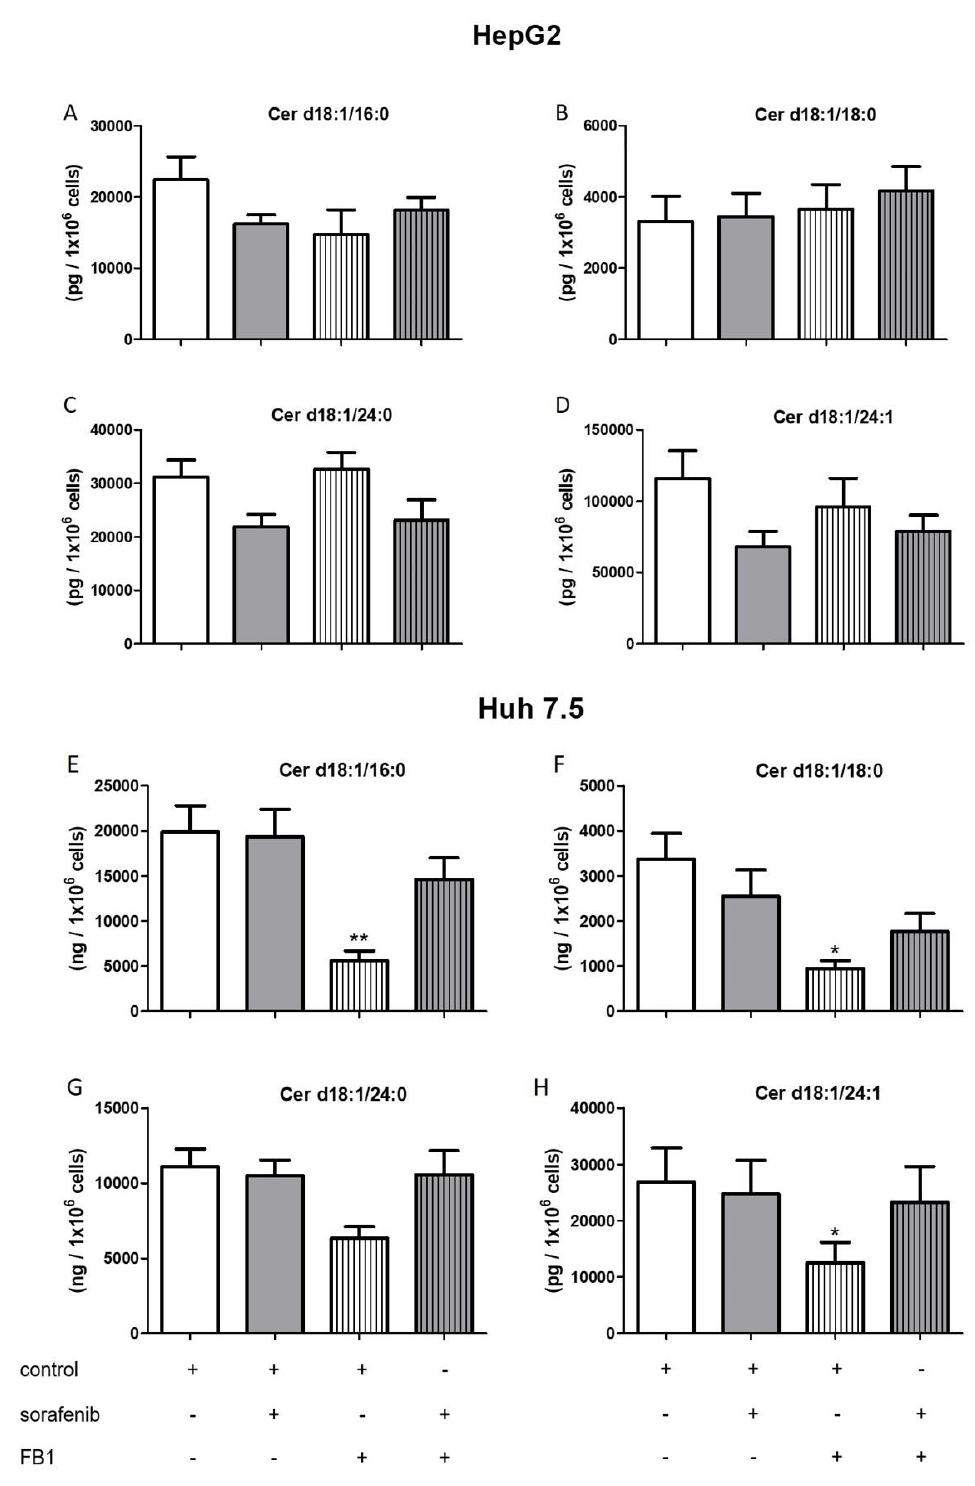
Figure 6. Influence of sorafenib and FB1 on concentrations of d18:1 ceramides in HepG2 and Huh7.5 cells. The lipids were measured by LC-MS / MS. The cells (HepG2 in ( A )–( D ) and Huh7.5 in ( E )–( H )) were treated with or without 25 µ M FB1 for 1 h before the addition of vehicle (control; 0.2% DMSO) or 5 µ M sorafenib and further incubation for 24 h. All results are presented as means ± SEM of 3–6 independent experiments. * p < 0.05, ** p < 0.01 compared to control in one-way ANOVA followed by Bonferroni